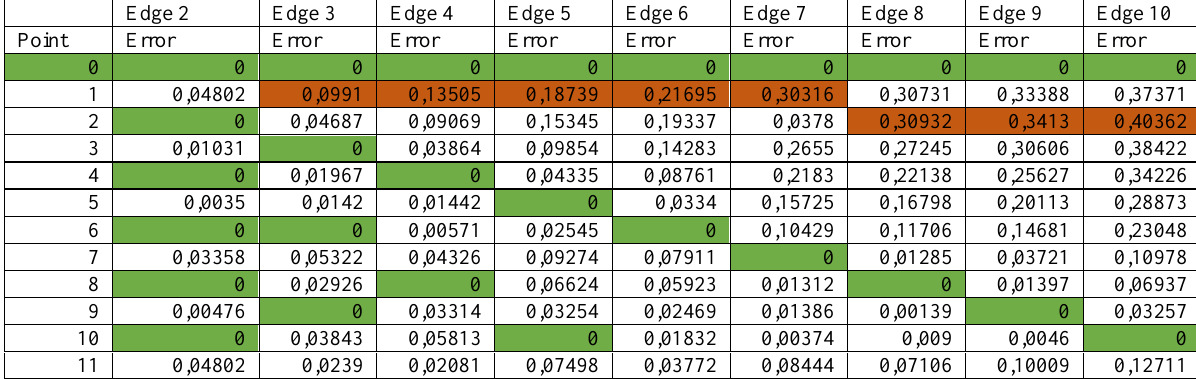
Table 1. result of measuring the deviation of the cutting edges from the nominal